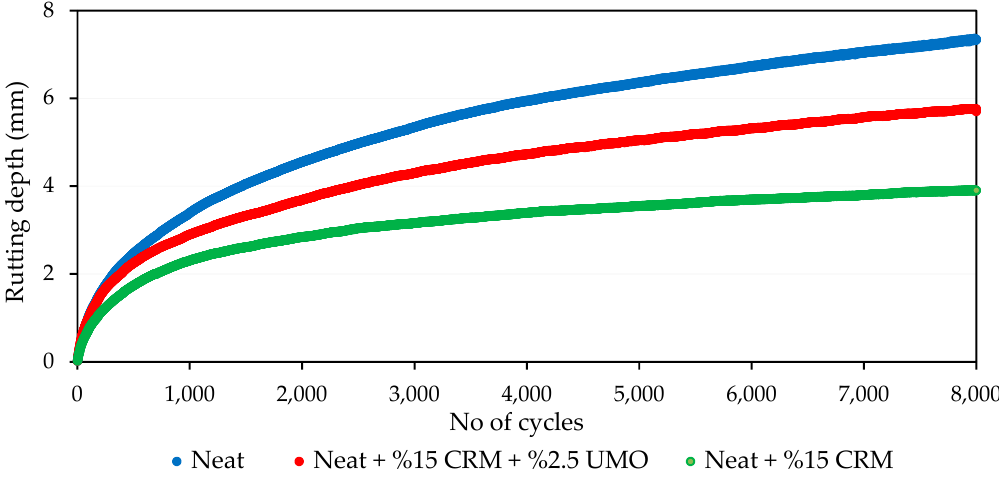
Figure 16. Rutting depth for PG 52-28 neat and modified asphaltic mixtures samples (APA testing).